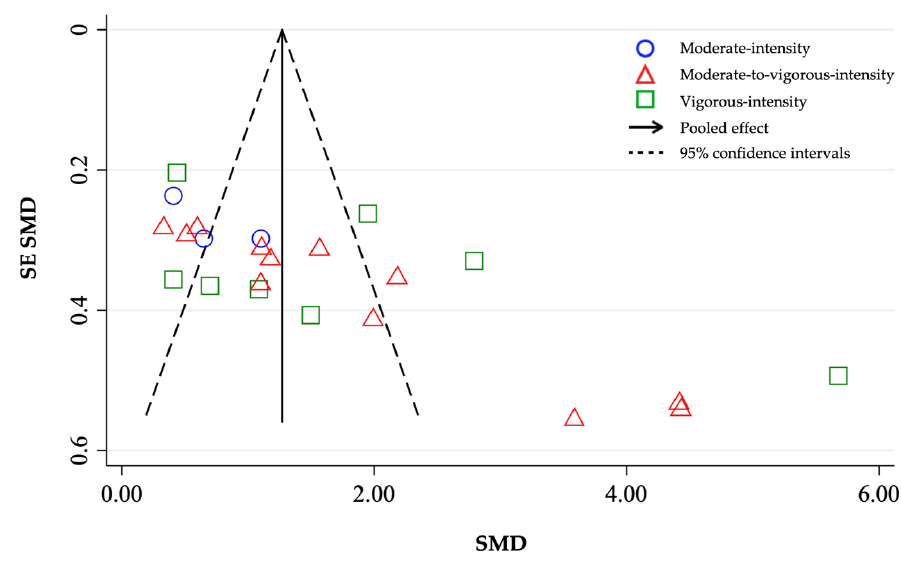
Figure 5. Funnel plot with pseudo 95% confidence intervals for change in relative VO 2 peak (mL-kg −1 -min −1 ) by exercise intensity (moderate, moderate-to-vigorous, vigorous). SMD, standardized mean difference. SE SMD, standard error of standardized mean differences.